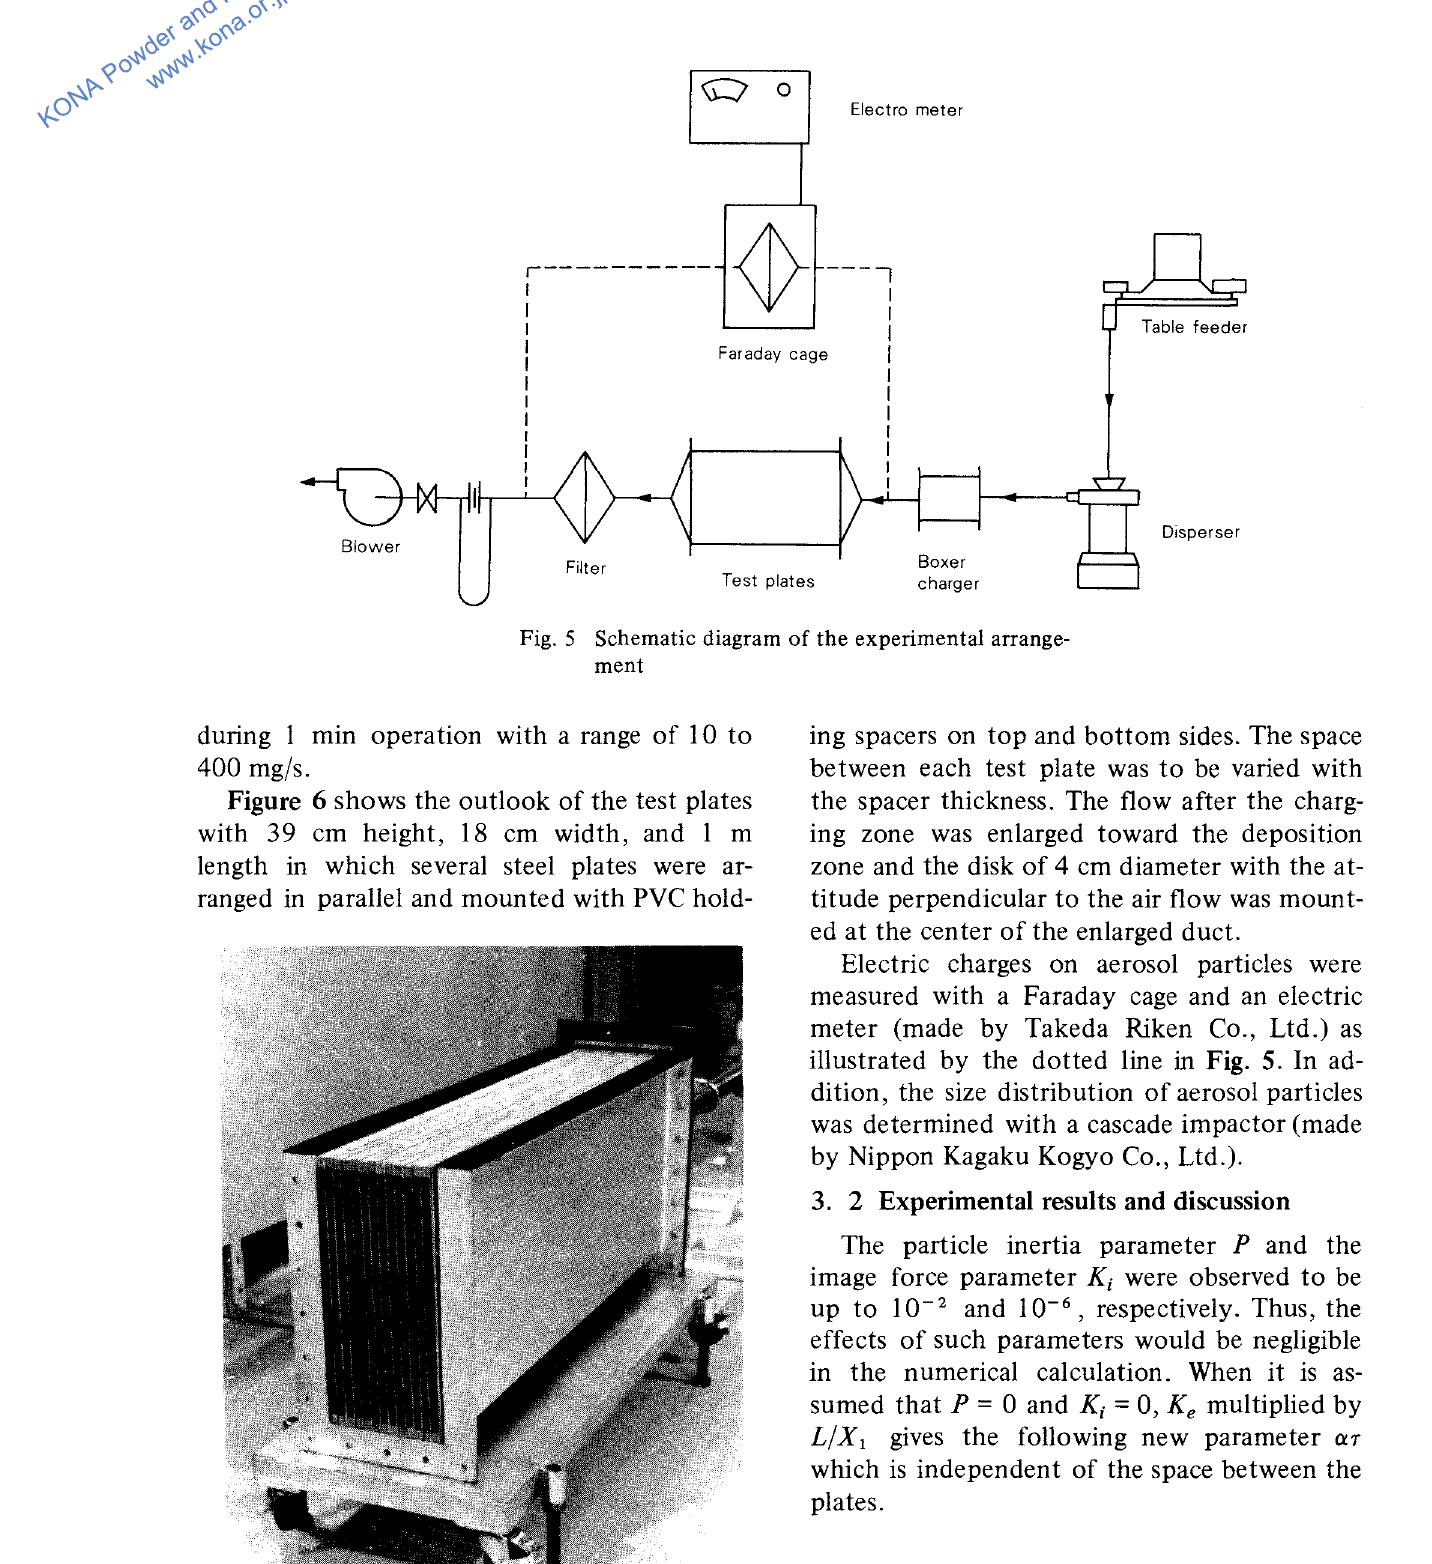
Fig. 6 Photograph oft est plates (upper and connection parts are dismounted)